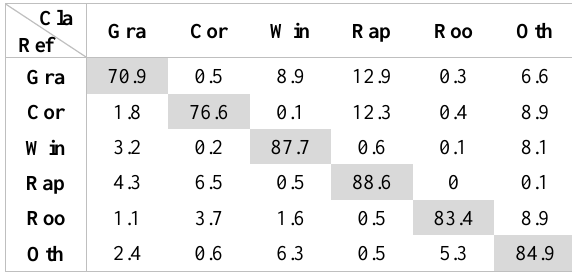
Table 3. Confusion matrix for SVM-classification